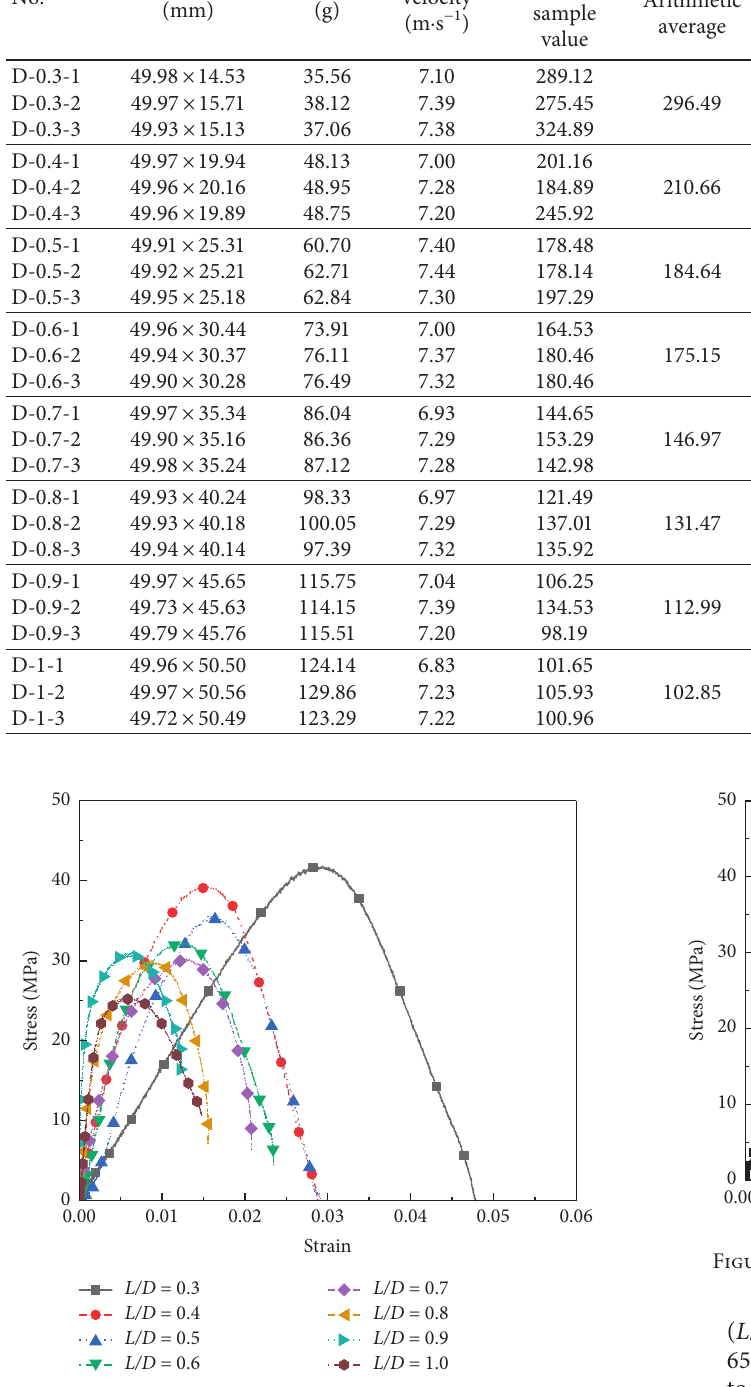
Figure 3: Stress-strain curve of coal with different L / D ratios.